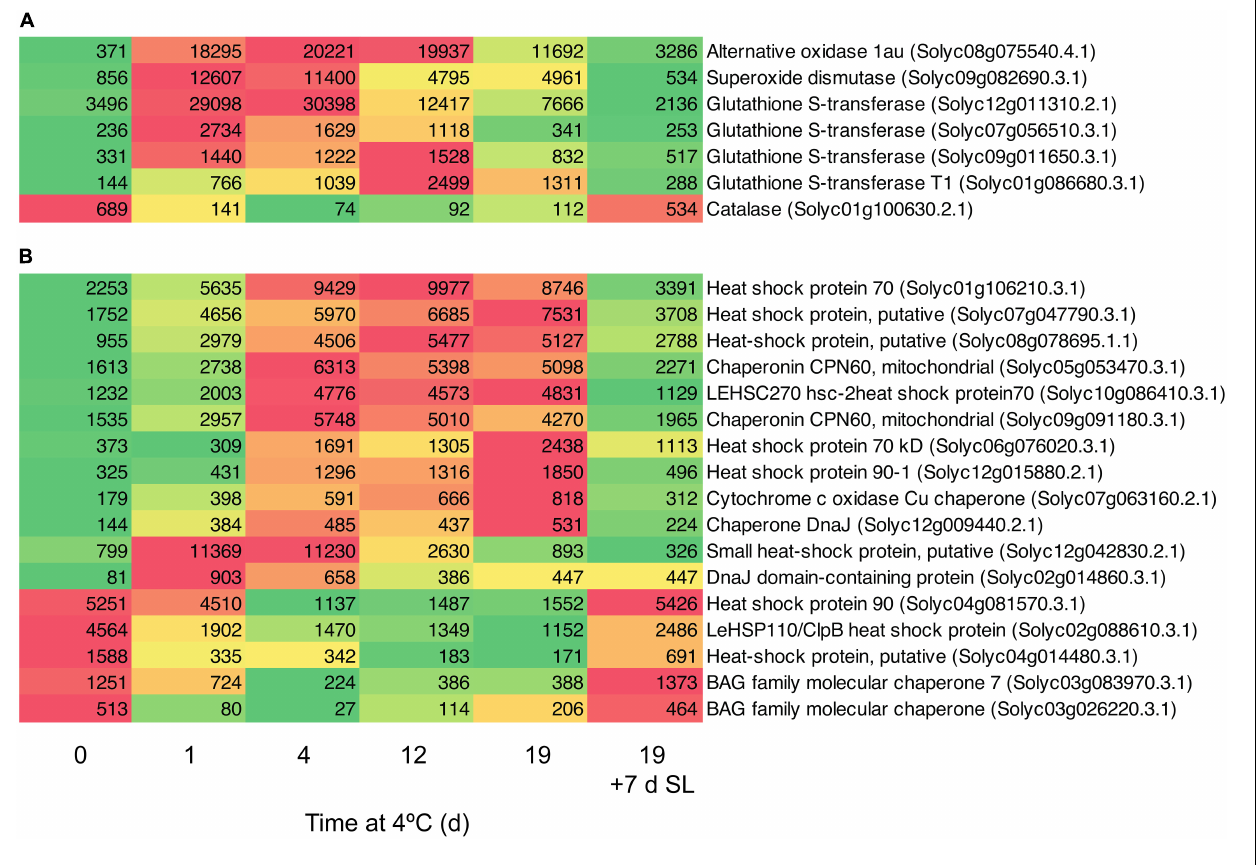
FIGURE 5 | Heat maps showing stress-related genes differentially expressed in response to storage at 4 ◦ C. An additional 7-day period at a shelf-life (SL) temperature of 20 ◦ C was also included after 19 days. (A) Genes encoding enzymes involved in oxidative stress. (B) Genes encoding heat shock and molecular chaperone proteins. Red and green colors represent high and low mRNA abundance, respectively, within each transcript. Numbers in the boxes are DESeq2 mean normalized counts using the median of ratios